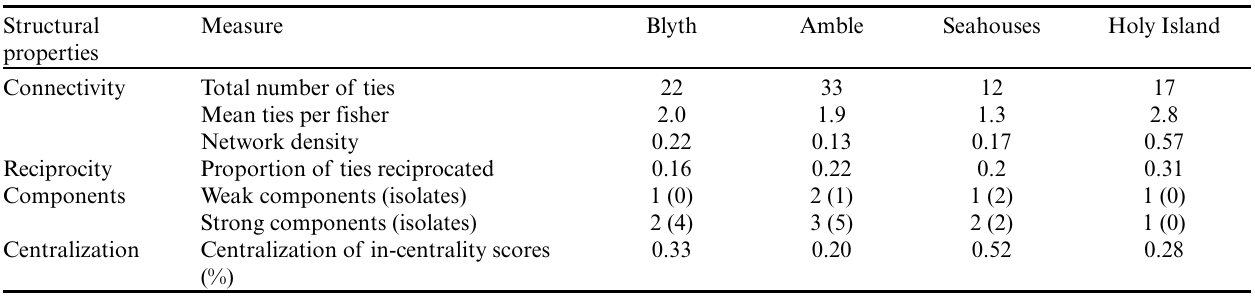
Table 2 . Summary of information-sharing networks reported in four ports. Components include more than one fisher; isolates are fishers that are not connected to any others.